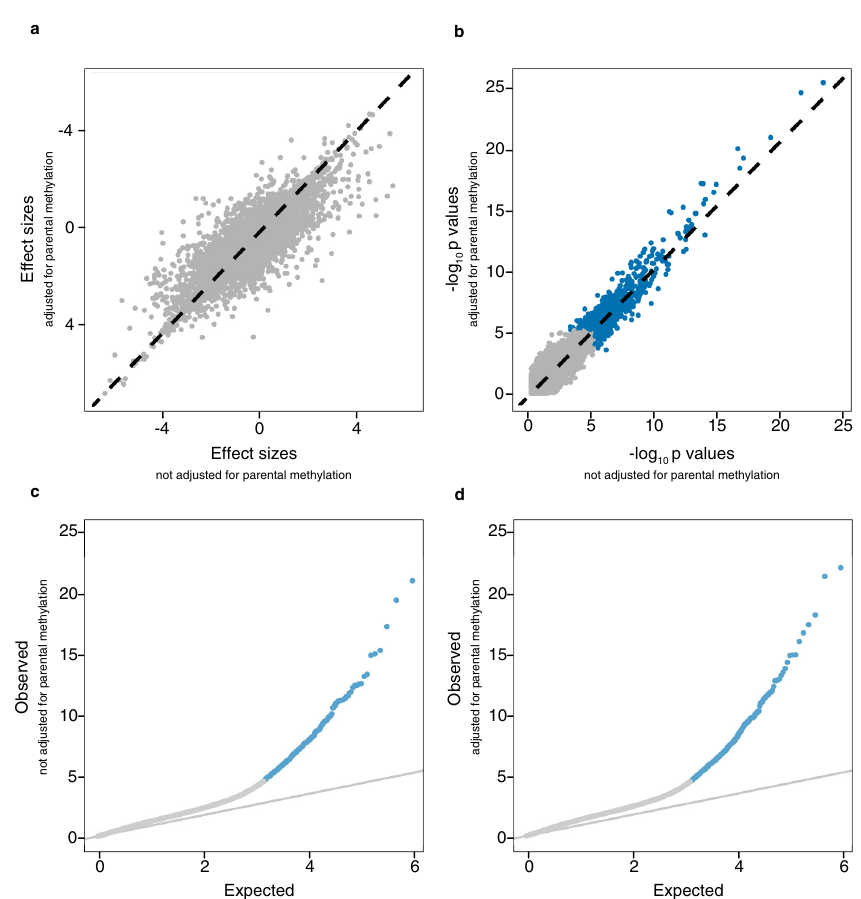
Fig. 6 Comparison of the size of effects and P values with and without adjustment for parental methylation. The effect sizes and observed − log 10 P values (calculated from t statistics) were derived from two-sided t tests for comparing the DNA methylation levels between ART conceived newborns ( n = 962) and naturally conceived newborns ( n = 983). a The effect sizes on the x -axis were adjusted for maternal age, maternal smoking, maternal BMI before pregnancy, parity, child sex, and plate number, and the effect sizes on the y -axis were adjusted for all the covariates listed and parental methylation. The Pearson ’ s correlation coef fi cient was 0.95. b The observed − log 10 P values were calculated from the effect sizes in panel ( a ) and their standard errors. Blue dots indicate the signi fi cant CpG sites at FDR < 0.01, while gray dots indicate nonsigni fi cant CpG sites. c The expected − log 10 P values adjusted for maternal age, maternal smoking, maternal BMI before pregnancy, parity, child sex, and plate number are on the x -axis, and the observed P values are on the y -axis. Blue dots indicate the signi fi cant CpG sites at FDR < 0.01, while gray dots indicate nonsigni fi cant CpG sites. The slope in gray indicates the null distribution of no differences between ART and naturally conceived. d The expected − log 10 P values adjusted for maternal age, maternal smoking, maternal BMI before pregnancy, parity, child sex, plate number, and parental DNA methylation are on the x -axis, and the observed P values are on the y -axis. Blue dots indicate the signi fi cant CpG sites at FDR < 0.01, while gray dots indicate nonsigni fi cant CpG sites. The slope in gray indicates the null distribution of no differences between ART and naturally conceived. Source data are provided as a Source Data